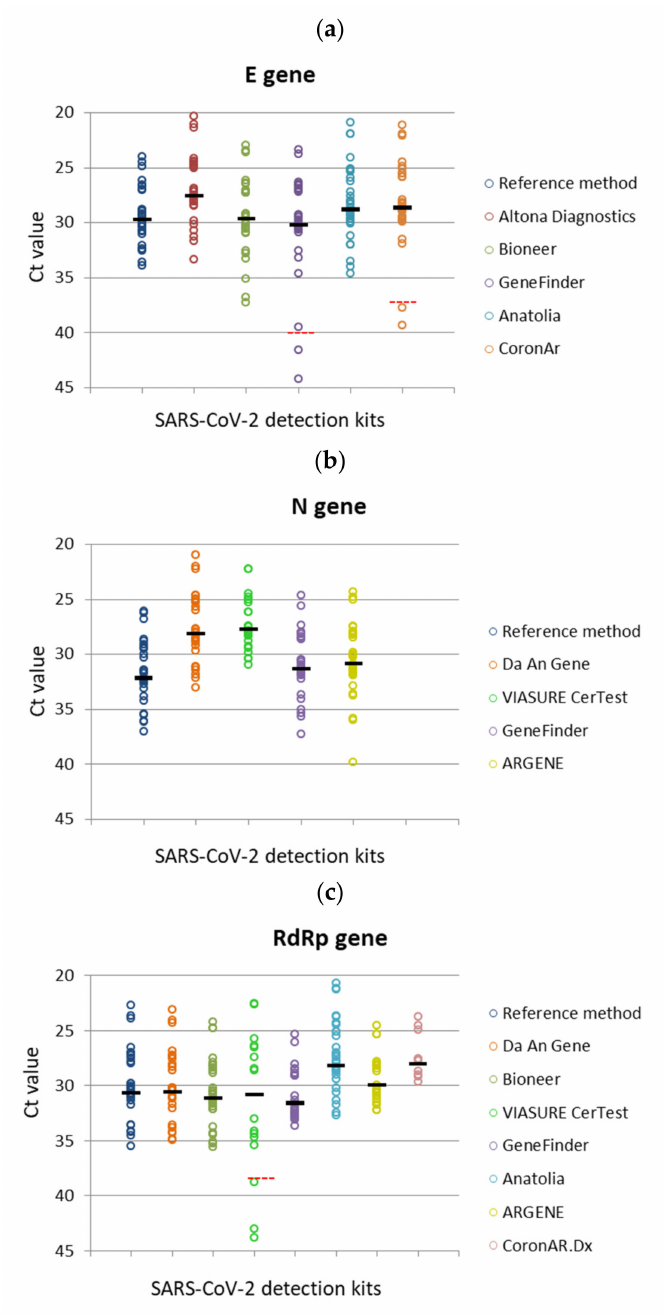
Figure 3. Distribution of the Ct values for the genesdetected using the RT-qPCR detection kits. ( a ) E gene, ( b ) N gene, ( c ) RdRp gene. The Ct values observed for the E, N and RdRp target genes during the amplification of the panel of positive samples with each of the RT-qPCR kitsare depicted. The circles correspond to the Ct values reached by each of the target genes amplified with the kits analyzed. The ratio above the circles indicates the rate of positive results regarding the total number of samples of the